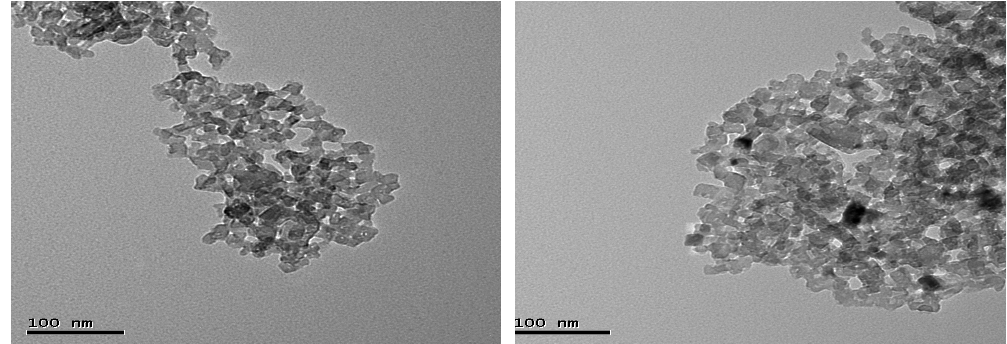
Figure 1. Transmission electron microscopic images of nano CrPic nanoparticles.